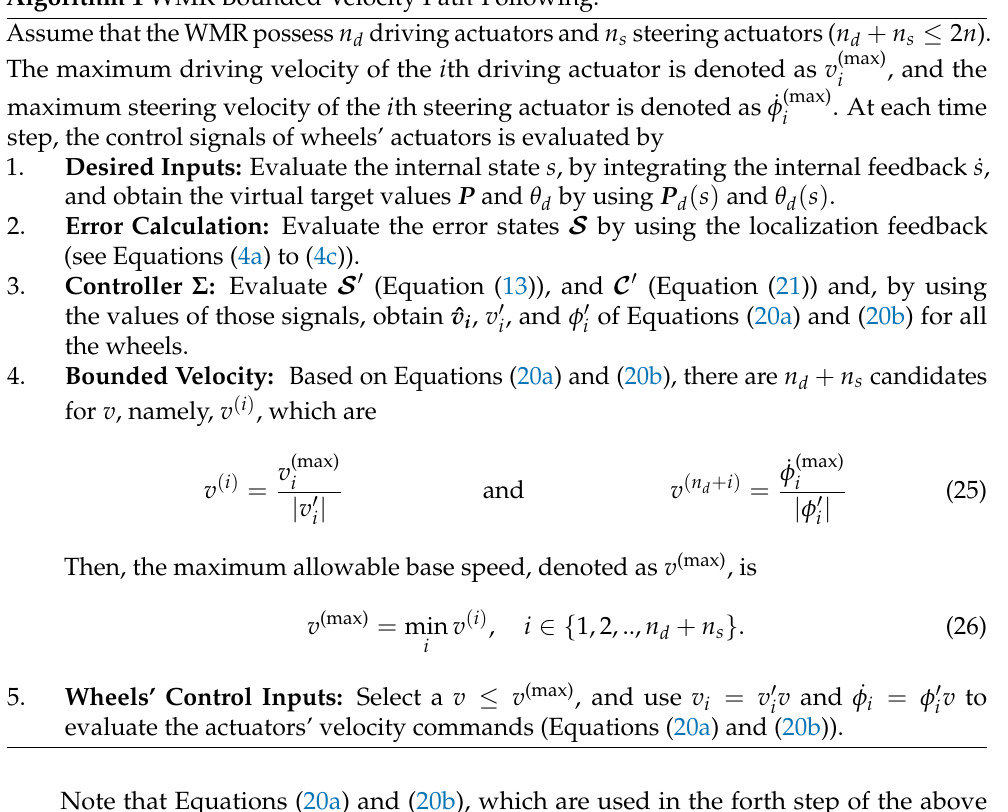
Algorithm 1 WMR Bounded Velocity